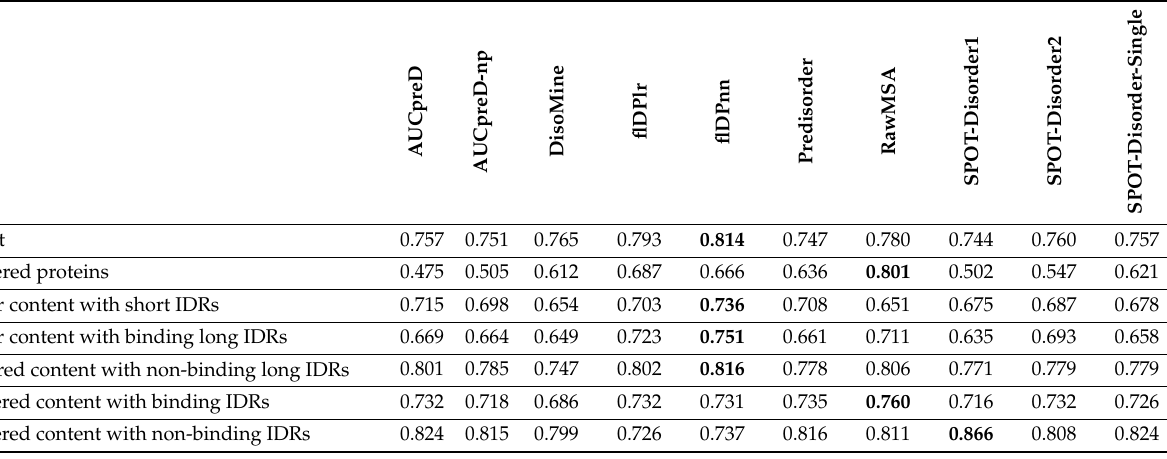
Table 2. Predictive performance measured with AUC for the top ten disorder predictors on the CAID dataset and for the six types of IDPs from the CAID dataset. The bold font identifies the methods that secure the highest AUC for a given collection of IDRs. Predictors are sorted alphabetically. article